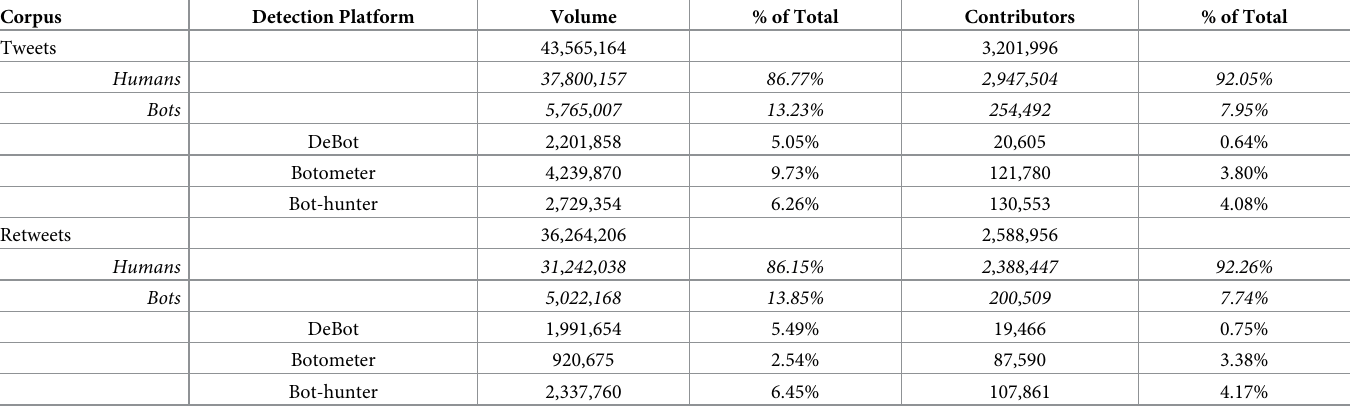
Table 2. Twitter corpus volume and contributor populations from the 2018 U.S. midterm election OSN conversation with associated bot detection platform classifi- cation results.